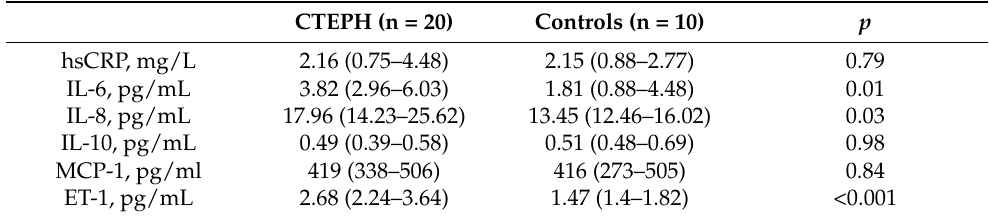
Table 2. Comparison of serum concentrations of selected biomarkers between patients with CTEPH and control